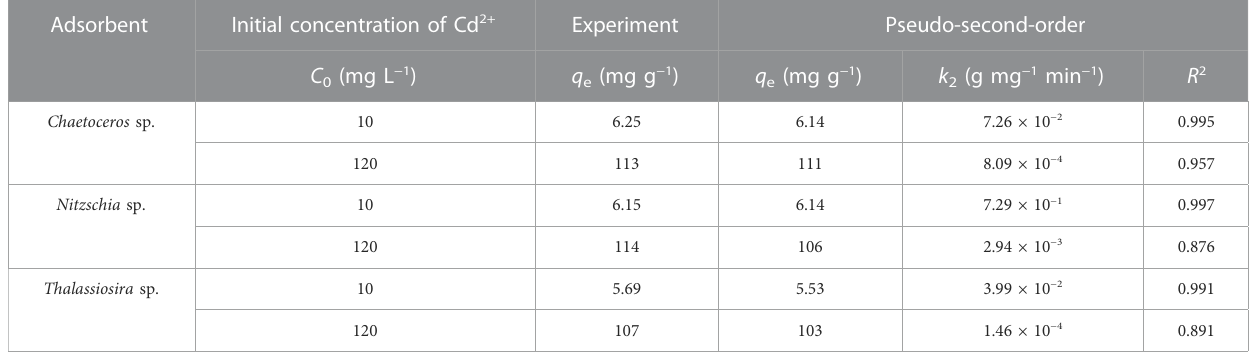
TABLE 1 Kinetic parameters for Cd(II) adsorption onto various non-living marine diatom biomass. Adsorbent Initial concentration of Cd 2+ Experiment